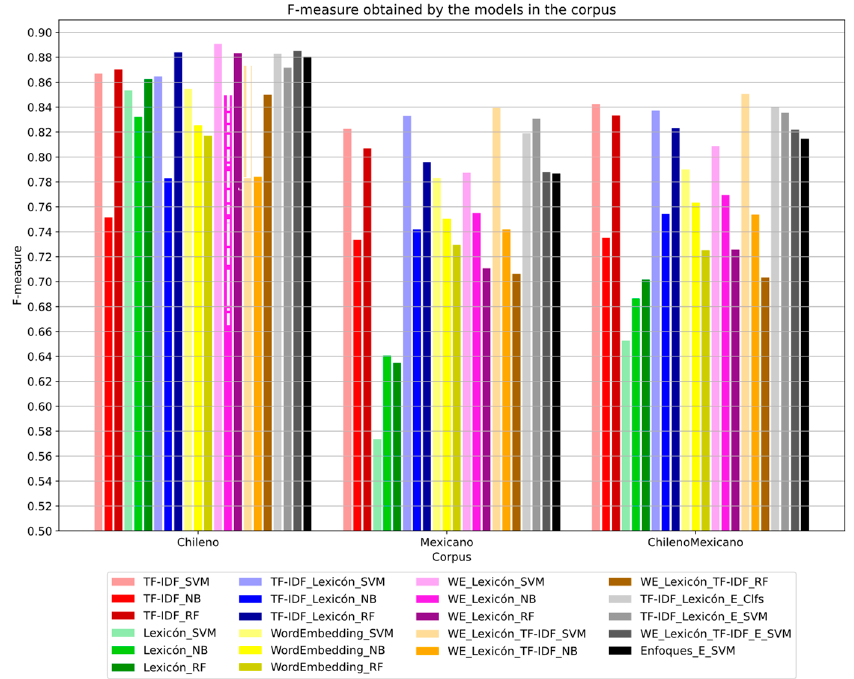
Figure 15. Comparison of F-measure obtained by the models.